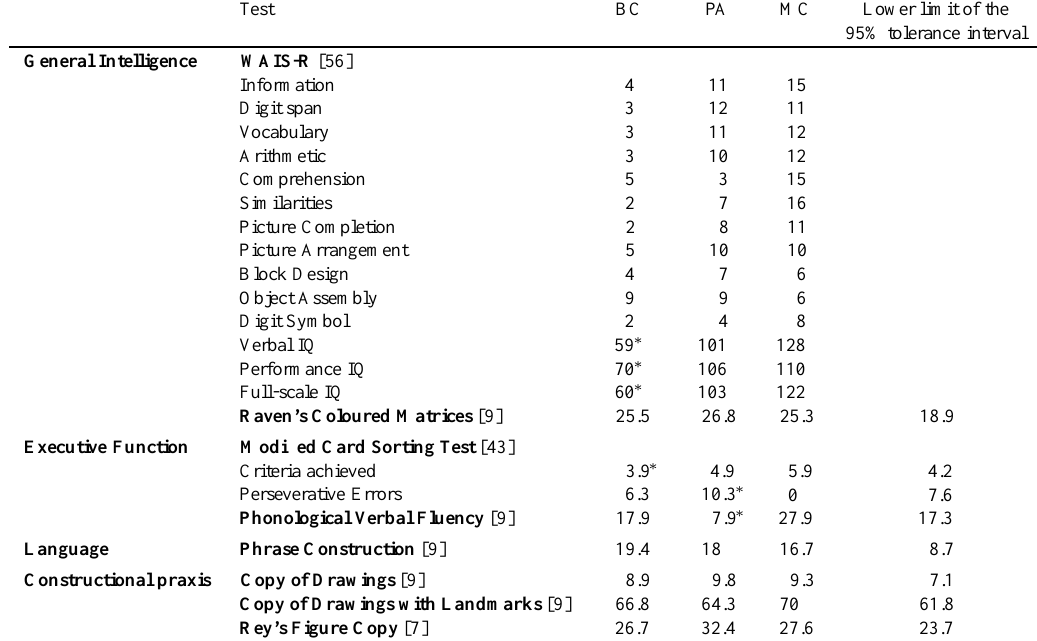
Table 3 Amnesic patients’ performance scores on tests of the general neuropsychological battery. With the exception of the